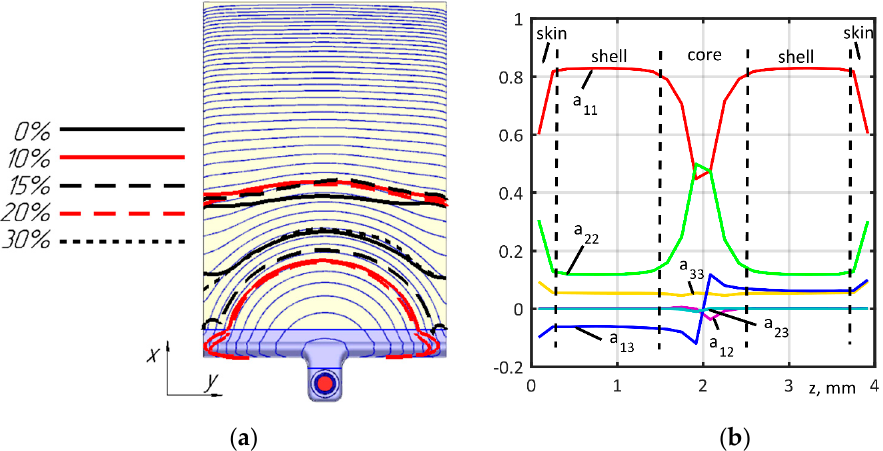
Figure 8. Comparison of simulated and experimental filling: ( a ) Melt front, blue lines—calculated isolines at each 2% of filling time, black and red lines—experimentally obtained melt fronts; ( b ) Orientation tensor components, solid lines—calculated values, dash lines—mean experimentally obtained zones sizes. Table 1. Calculated fiber orientation tensor components.